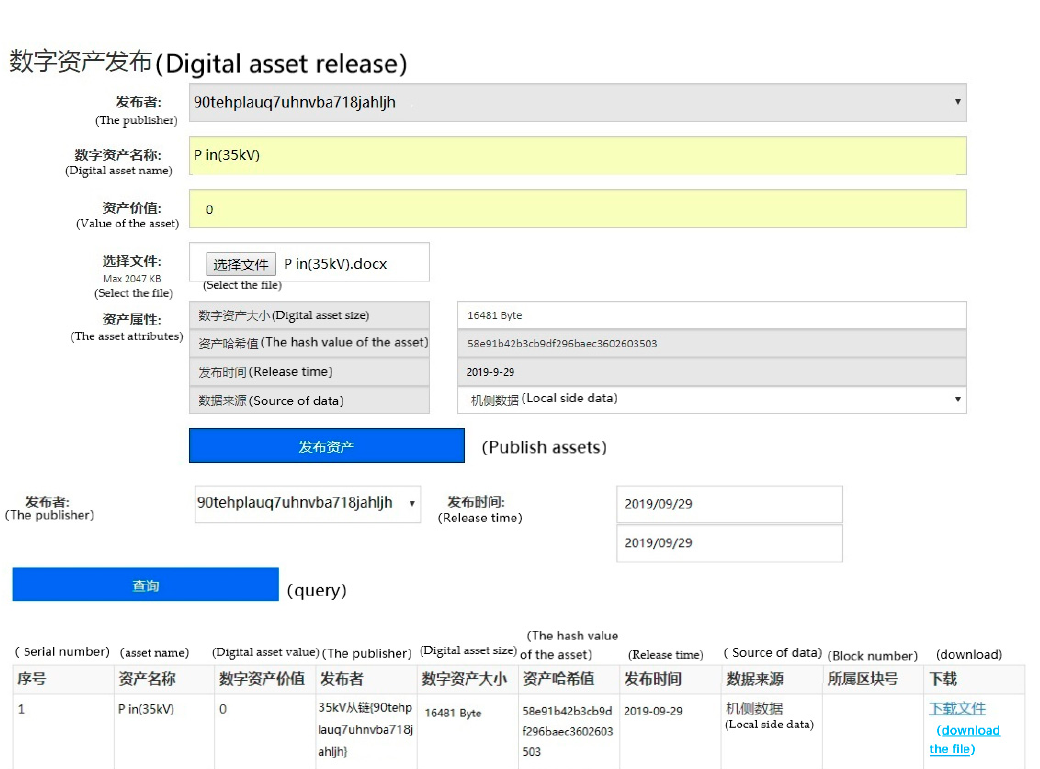
Figure A6. Chain110kV releasing scheduling data, and data asset information downloading.